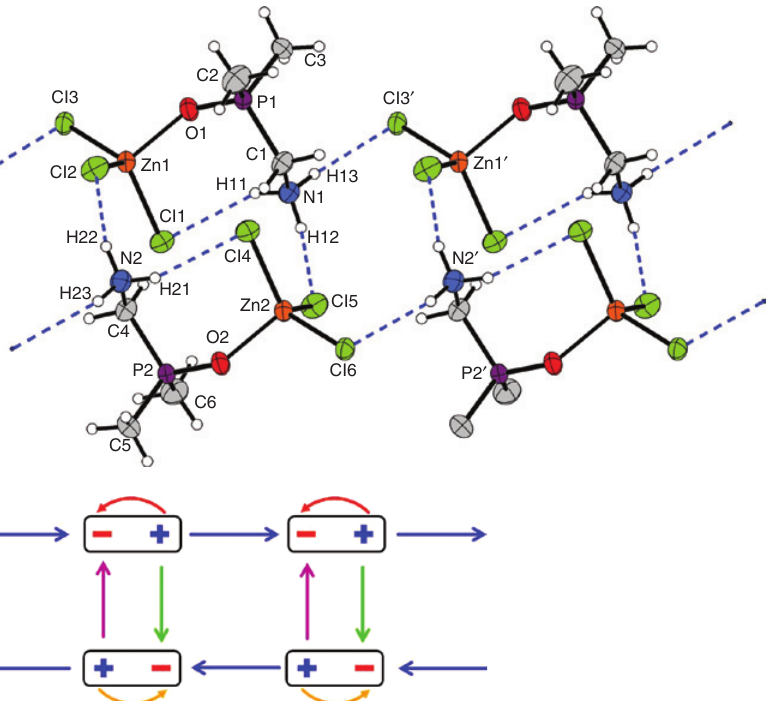
Figure 3: Upper part: the crystal structure of the tetragonal polymorph 6b is shown. Hydrogen bonds are indicated by blue fragmented lines. Ellipsoids are drawn at the 40% probability level; symmetry code: ′ = 1 + x , y , z . Lower part: constructor graph of the hydrogen-bonded connection of the title complex in 6b ; crystallographically related hydrogen bonds are coded by the colors.